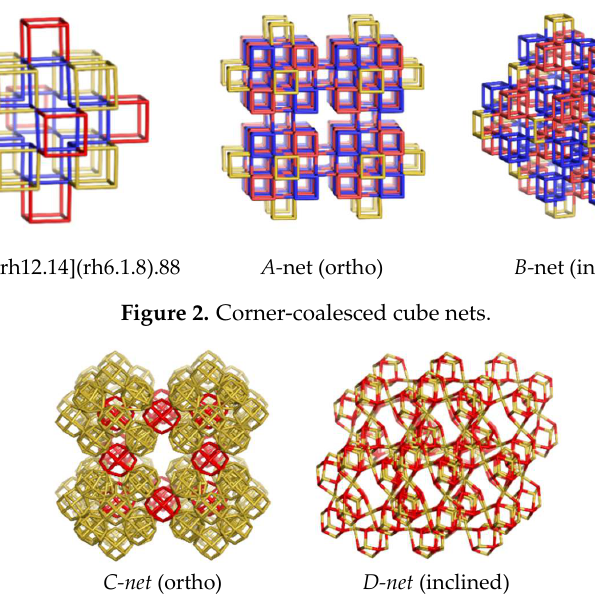
Figure 3. Rhombellated nets of Figure 2.